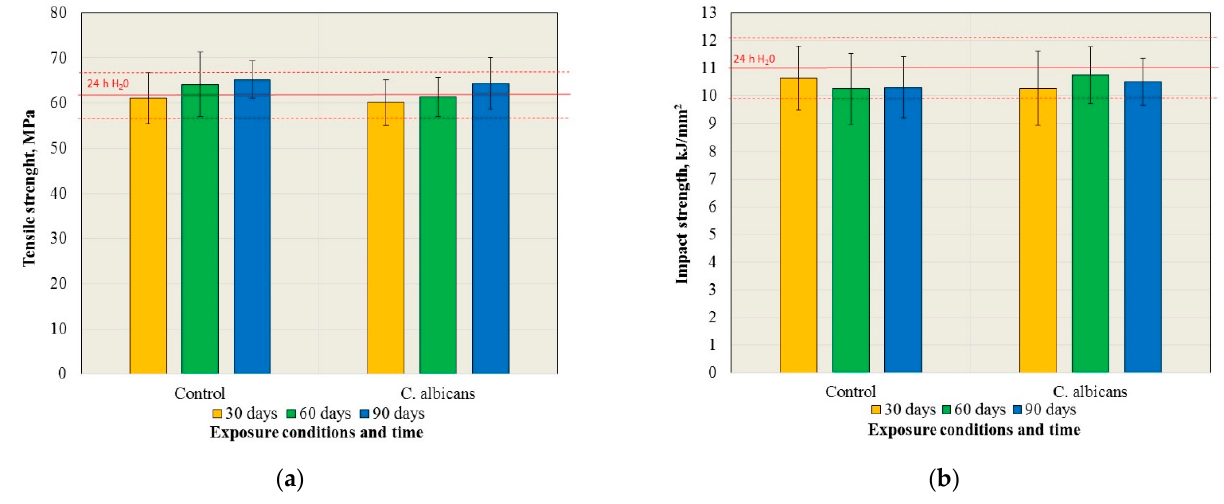
Figure 1. The mean values of the tensile strength ( a ) and impact strength ( b ) with the standard deviations after exposure to the control medium and the C. albicans suspension.